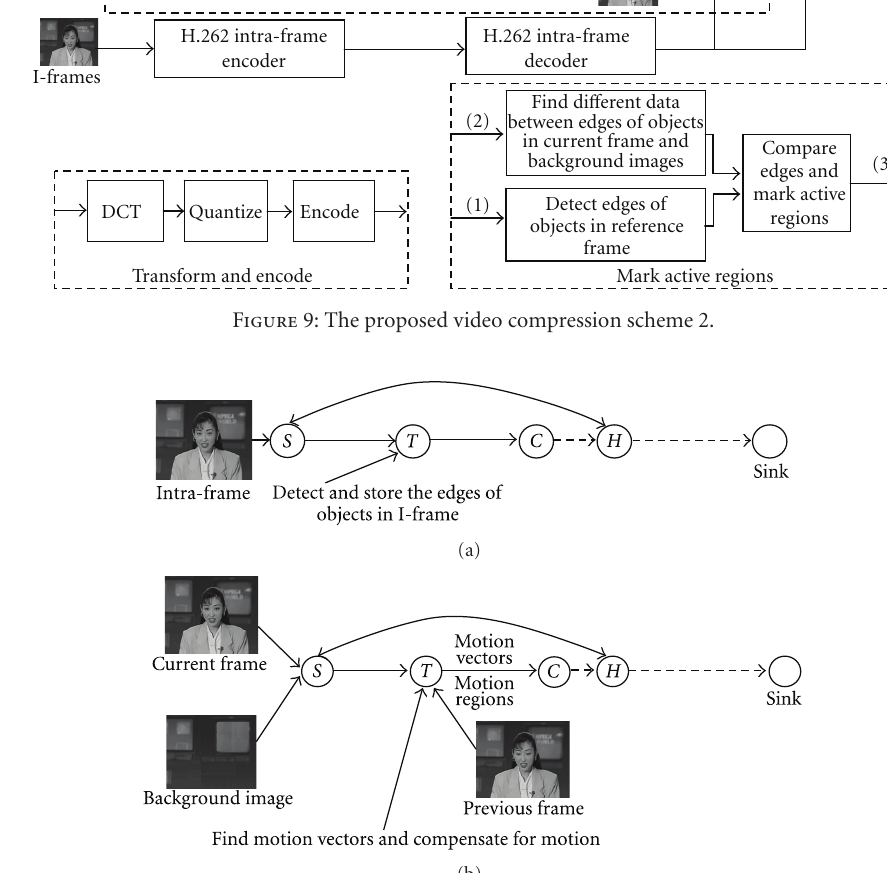
compressed by H.262 encoder along the path from the source node to the cluster head. In the figure, node T not only performs the transforming task but also detects and stores the edges of objects in the I-frames for motion estimation and motion compensation. The energy consumption in video compression for I-frame